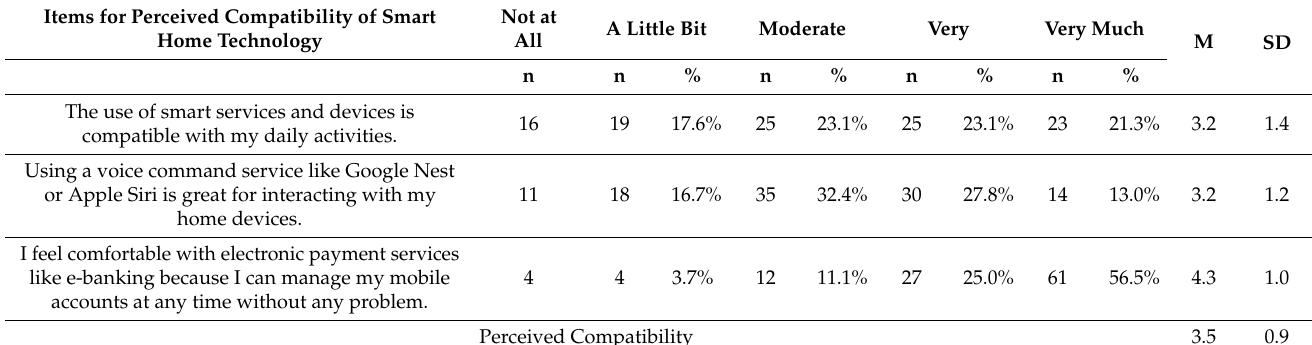
Table A3. Perceived compatibility of smart home technology.